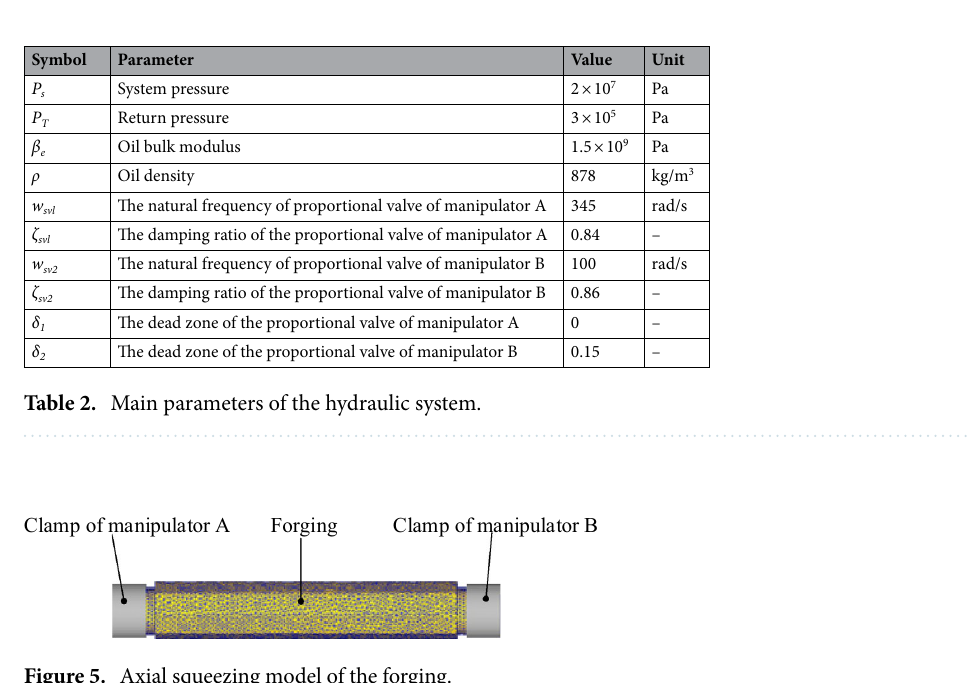
Figure 5. Axial squeezing model of the